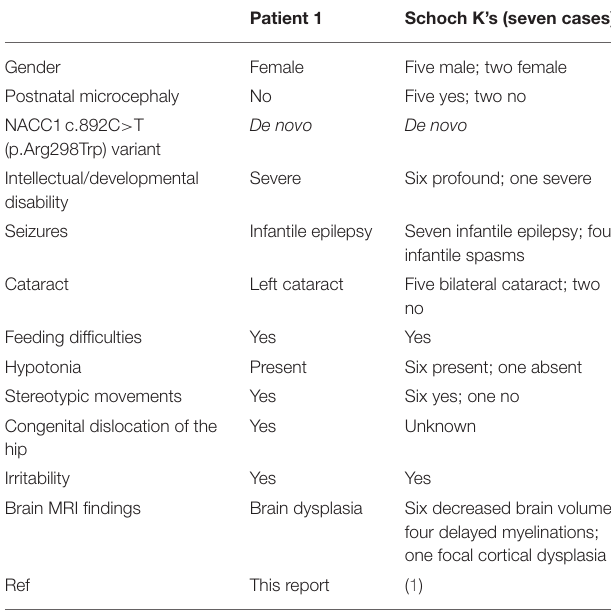
TABLE 1 | Phenotypic features of all patients with NACC1c.892C > T (p.Arg298Trp) variant published to